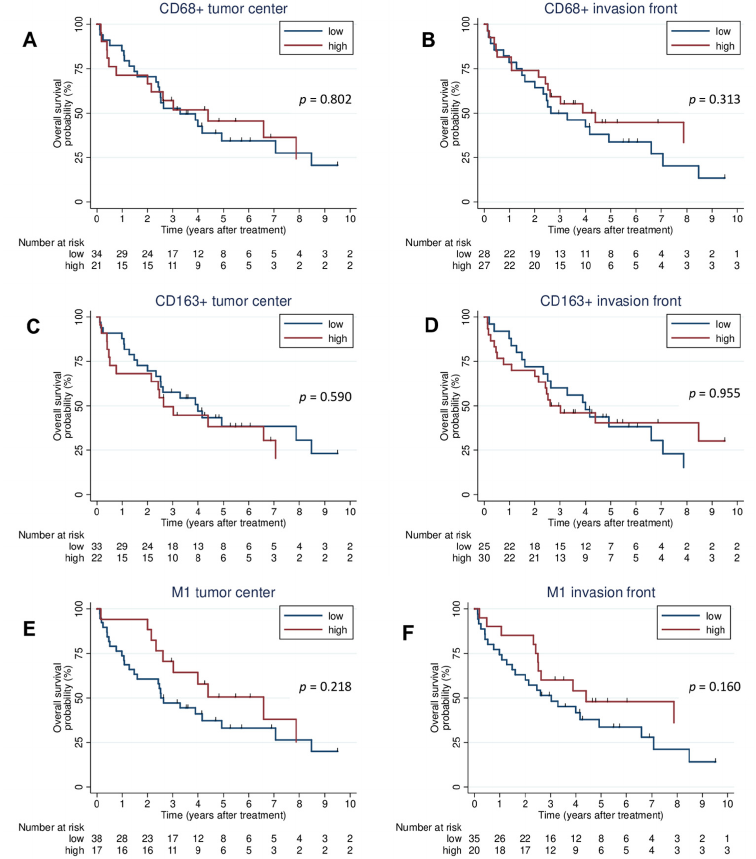
Figure 3. Survival analysis. Kaplan–Meier plots of OS for CD68+ in the tumor center ( A ) and the invasion front ( B ), CD163+ in the tumor center ( C ) and the invasion front ( D ), and M1 macrophages in tumor center ( E ) and invasion front ( F ). OS: overall survival.